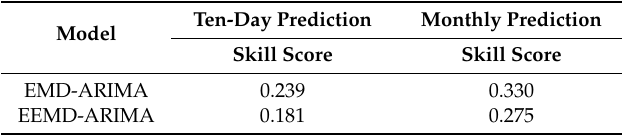
Table 2. Forecast skill score of hybrid